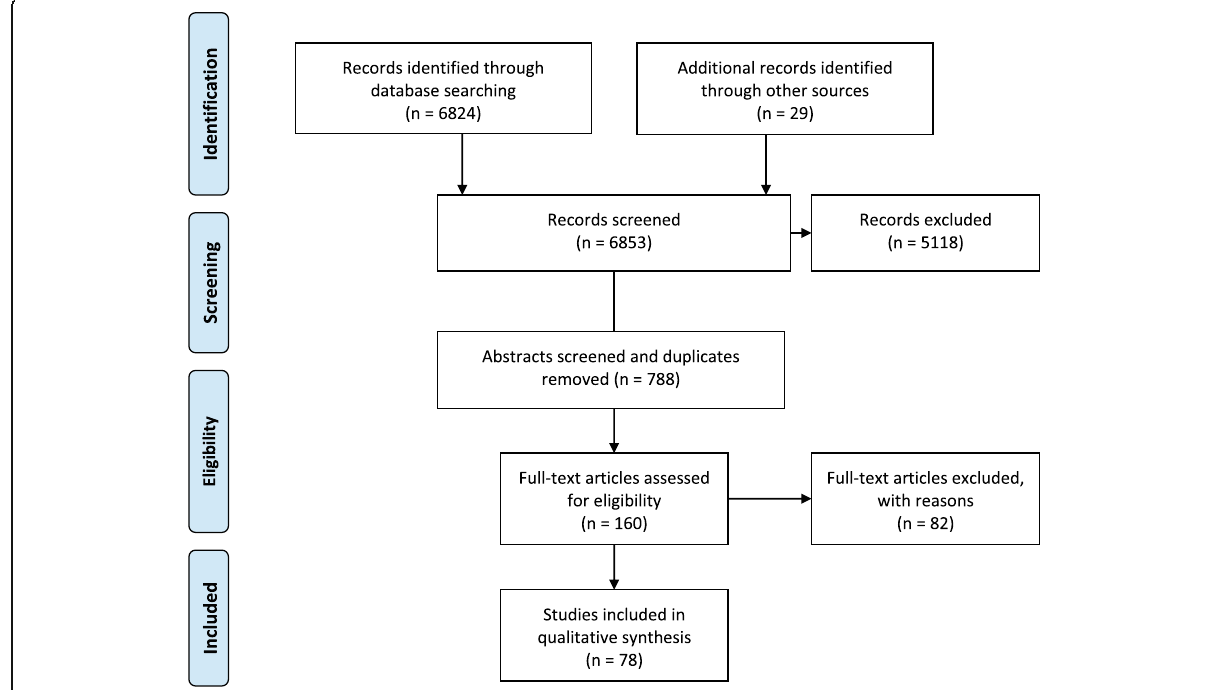
Fig. 1 PRISMA systematic review protocol diagram for the literature selection and narrative